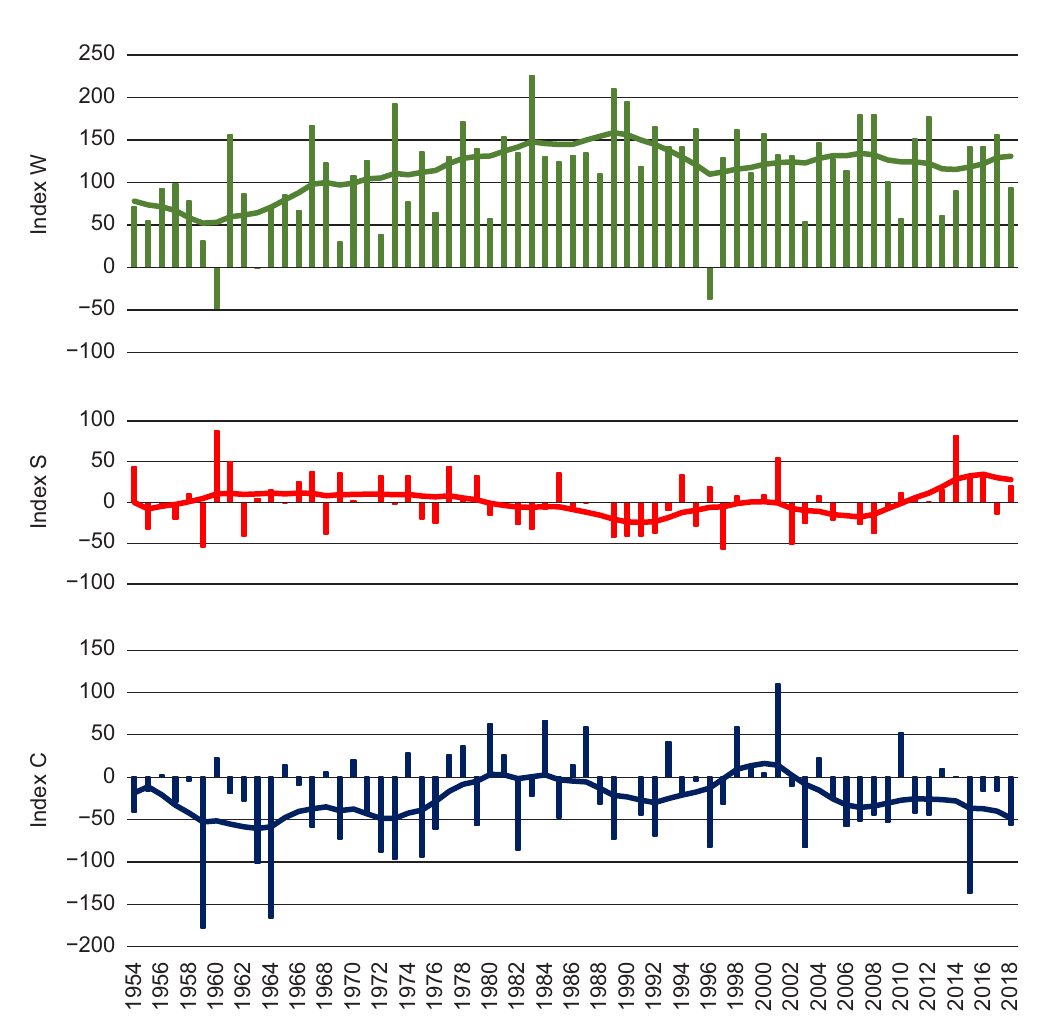
Fig. 4. The course of annual values of circulation indices (W, S and C) in the research area in 1954–2018 (hydrological year from November to October). Table 3. Characteristics of dry periods on the analysed rivers in 1954–2018.